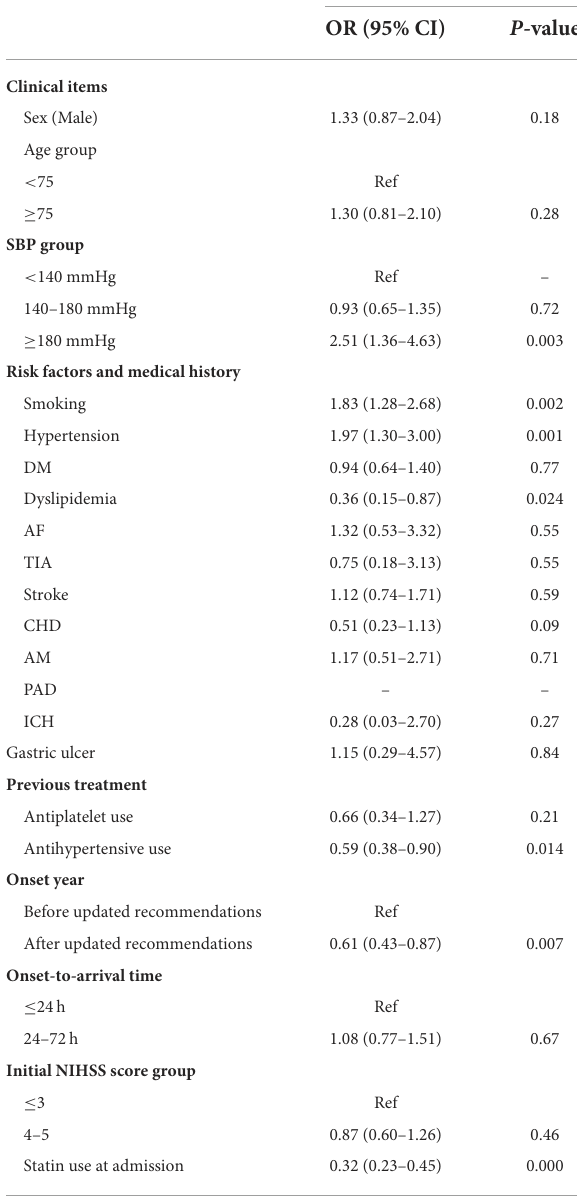
TABLE 3 Multivariate logistic regression analysis of DAPT-ALC and